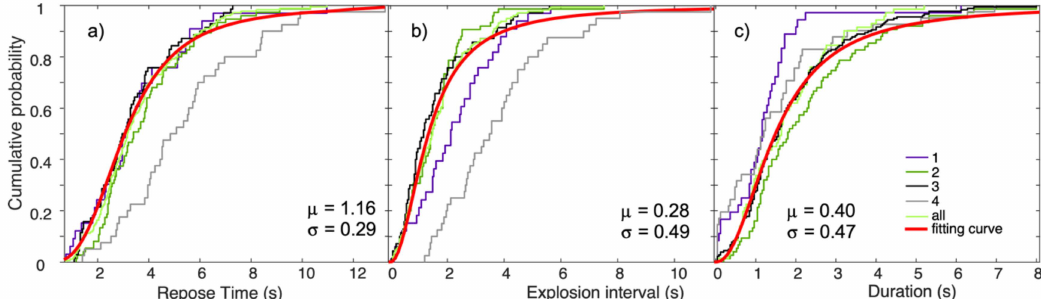
Figure 6. Cumulative probability plot of ( a ) repose times, ( b ) explosion intervals ( c ) explosion duration. The fitting curve corresponds to a log logistic distribution calculated over data from videos 1, 2, 3. The numbers in the legend indicate the label of videos as in Table 3. The red thick line (fitting curve) is the best log logistic distribution fitting the data from videos 1, 2, 3. The numbers in each plot refer to the scale ( µ ) and shape ( σ ) parameters of the best fit curve. See text for further details.